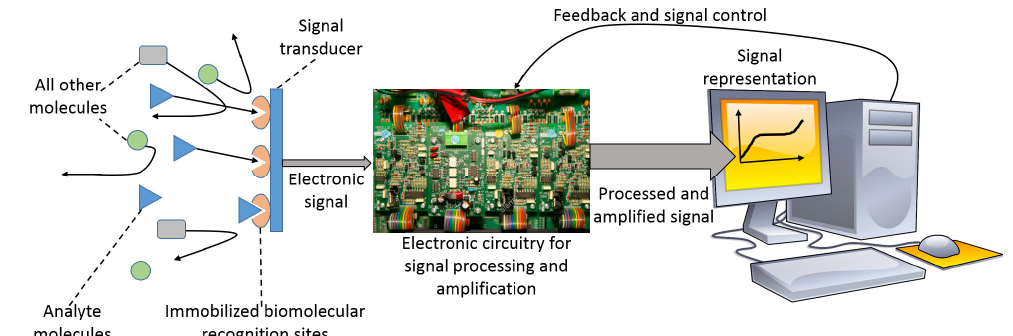
Figure 1. Schematic presentation of a biosensor. The analyte (bio)molecules can be selectively analyzed in a complex mixture containing many other molecules (different molecules are shown schematically with different shapes). The specificity in the analyte detection is provided by biomolecular species immobilized at the signal transducer interface. The electronic component of the biosensor provides the conversion of a chemical signal to an electronic signal with its amplification. The larger size of the second arrow shows an amplified signal. The computer, used in modern devices, allows convenient presentation of the output signal and its processing as needed for specific applications. Notably, the computer is usually miniaturized and integrated with the electronic signal processing part, not being a desktop device, as shown in the scheme for simplicity. It should be noted that many bioanalytical methods performed in solutions might be converted to respective biosensors, but this may not be practical to do. In other words, the technical simplicity and applicability may limit the realization of biosensors with a limited choice of molecule immobilization techniques and signal transduction methods, which are collected in Figure 2. The present review article will mostly overview biosensors based on electrochemical signal transduction methods, leaving many other biosensors to special reviews, which can be found elsewhere.